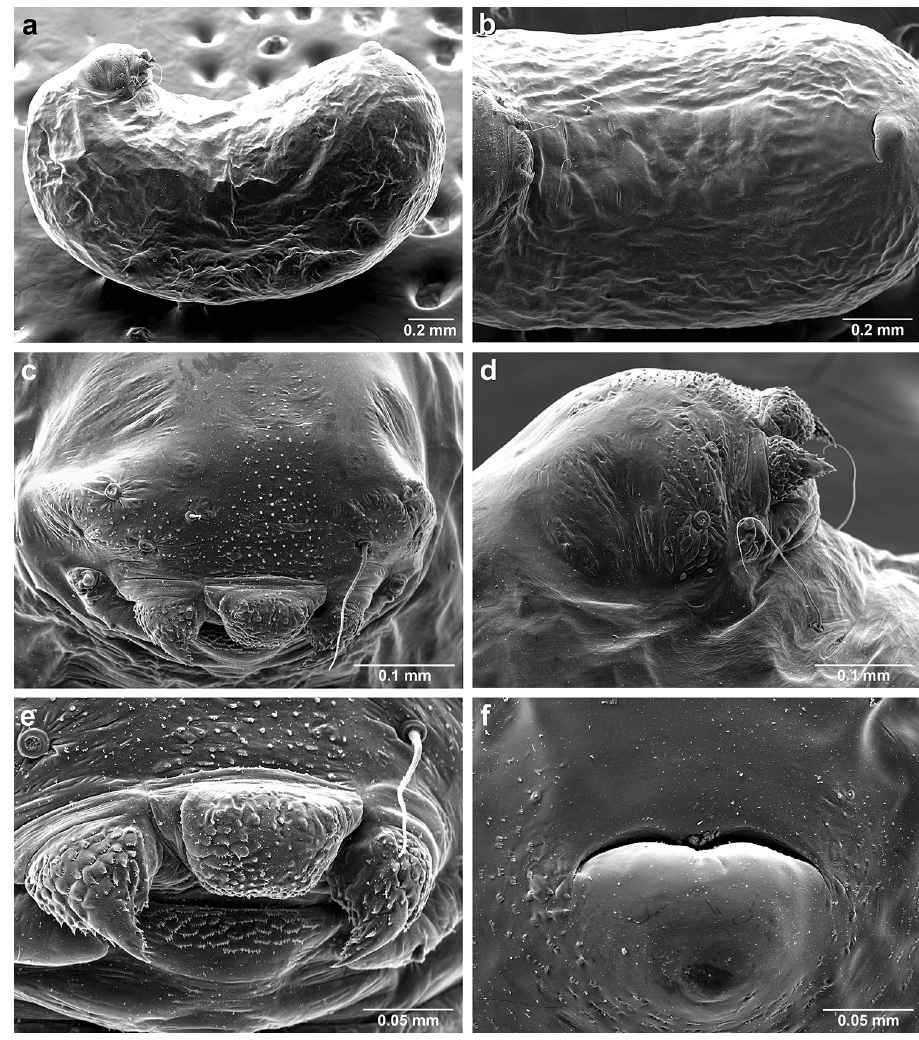
Figure 50. S. parvulus larva (USNMENT01125592), SEM images. a Lateral view b ventral view c head, frontodorsal view d head, lateral view e mouthparts f anal